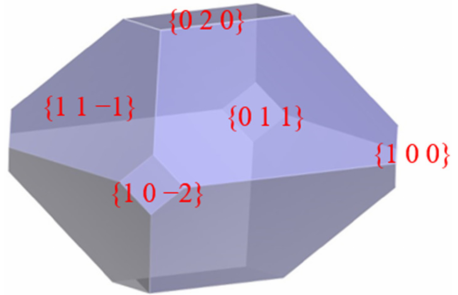
Figure 2. Crystal morphology of β -HMX in a vacuum by AE model.